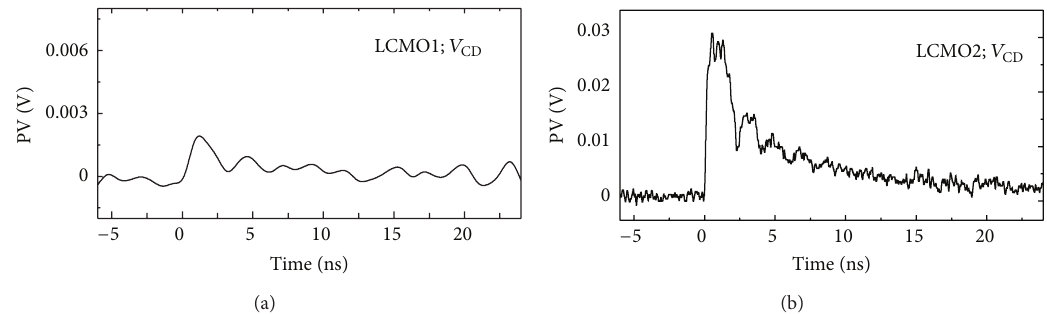
Figure 4: Photovoltaic responses of (a) the LCMO1 film (b) the LCMO2 film, under the illumination of a 355 nm laser pulse along the untilted ), recorded by the oscilloscope terminated into 50 Ω direction ( 𝑉 CD